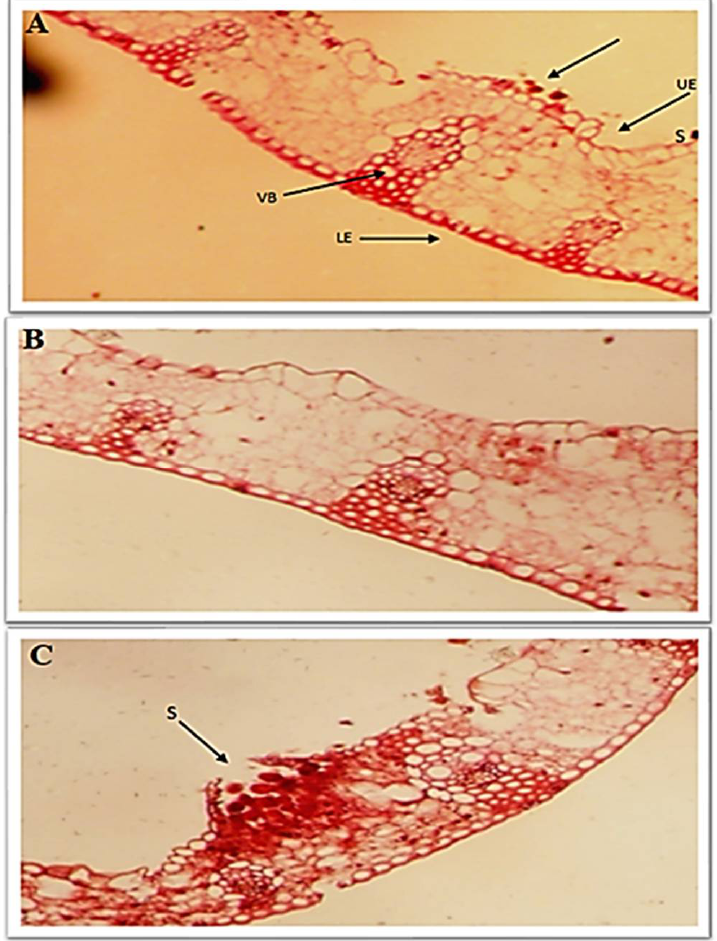
Figure 8. Transverse sections of salicylic acid ( A ) and chitosan nanoparticles ( B ) compared to the control ( C ). (Magnification × 100). Details:—UE: upper epidermis, VB: vascular bundle, MT: mesophyll tissue, S: urediniospores.